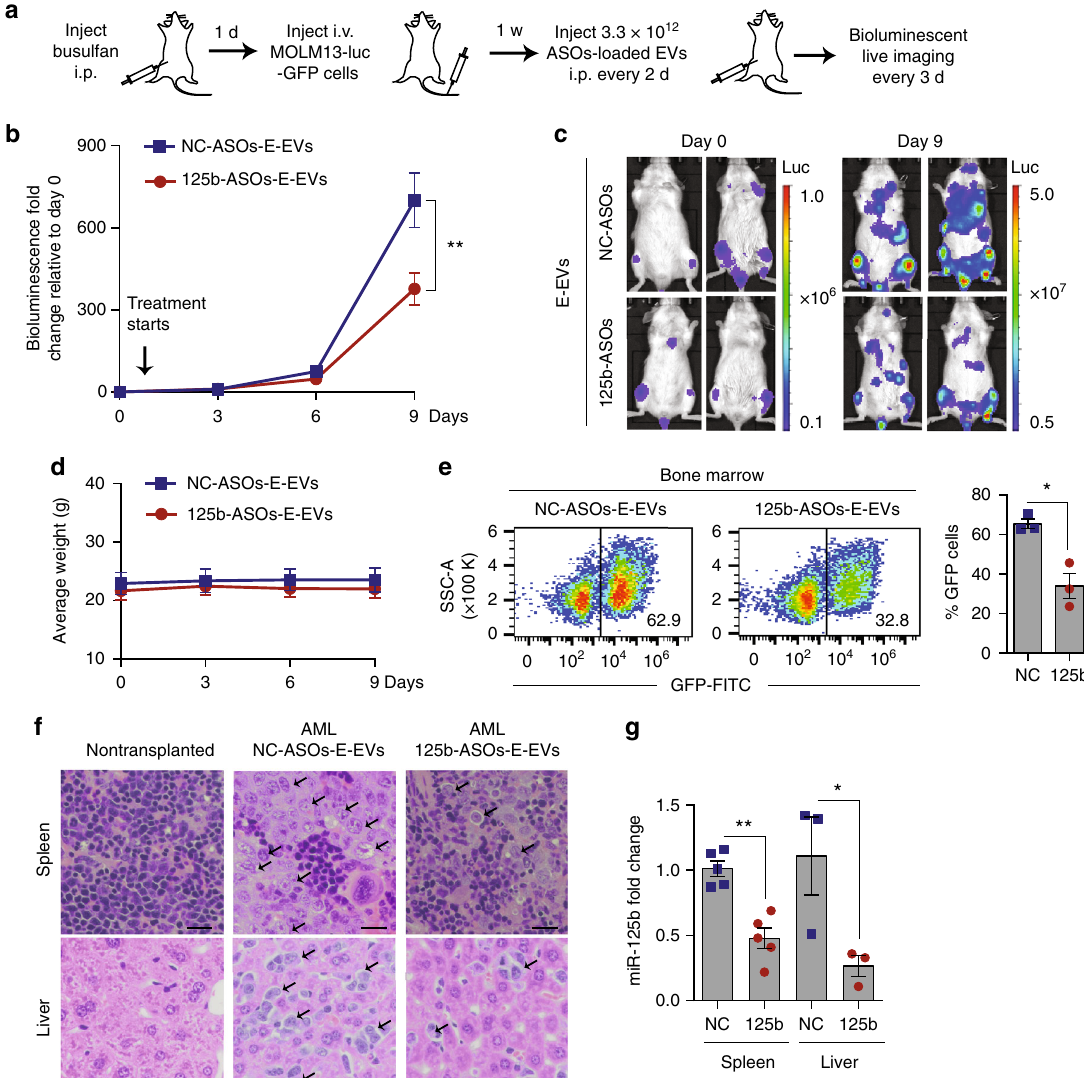
Fig. 7 Systemic delivery of miR-125b ASOs in RBCEVs suppresses leukemia progression in AML xenografted mice. a Experimental schema of AML xenografting and ASOs delivery in NSG mice. b Average fold change in total body bioluminescence of the mice after 0 to 9 days of treatment with 3.3 × 10 12 RBCEVs containing NC-ASOs ( n = 7 mice) or 125b-ASOs ( n = 6 mice) relative to the signals before the treatment started (day 0), determined using an IVIS (mean ± SEM). c Representative images of the leukemic mice on day 0 & 9, captured using the IVIS. Bioluminescence is shown in pseudocolors. d Average weight of the mice (mean ± SEM). e FACS analysis of GFP cells in the bone marrow of the leukemic mice: representative dot plot of GFP (FITC channel) vs. size scatter area (SSC-A) and the average percentage of GFP-positive cells (mean ± SEM, n = 3 mice/group). f Representative H & E staining images of the spleen and liver from a nontransplanted mouse and from AML mice treated with NC/125b-ASOs-loaded RBCEVs. Arrows indicate clusters of in fi ltrating leukemia cells that have larger nuclei than normal cells. Scale bar, 50 μ m. g miR-125b expression fold change normalized to U6B RNA in the spleen ( n = 5 mice) and liver ( n = 3 mice), determined using Taqman qRT-PCR and presented as mean fold change ± SEM relative to NC in the spleen. * P < 0.05; ** P < 0.01 determined using one-tail Mann – Whitney test ( b , e , g ). The whole experiment was performed in two independent